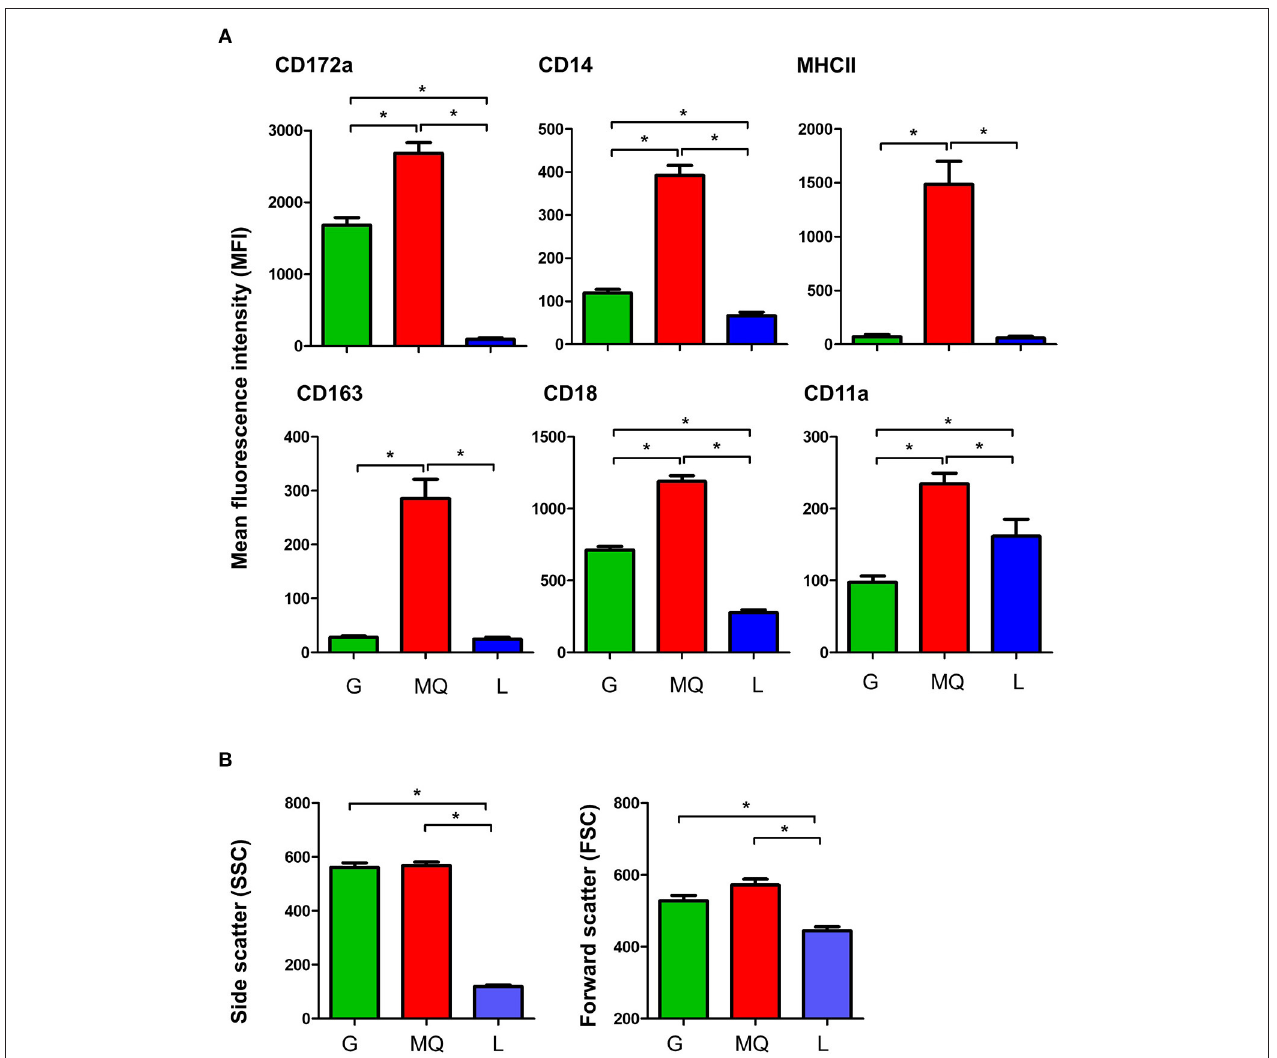
FIGURE 2 | (A) The expression levels of the cell surface antigens, CD172a, CD14, MHCII, CD163, CD18, and CD11a on milk granulocyte (G), macrophages (MQ), and lymphocytes (L) as measured by flow cytometry. (B) Forward and side scatter characteristics of milk granulocytes (G), macrophages (MQ), and lymphocytes (L) as measured by flow cytometry. *indicates statistically-significant difference between the means.